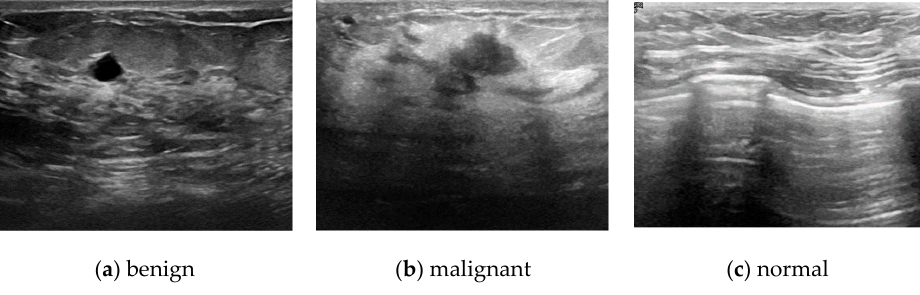
Figure 3. Breast ultrasound image.